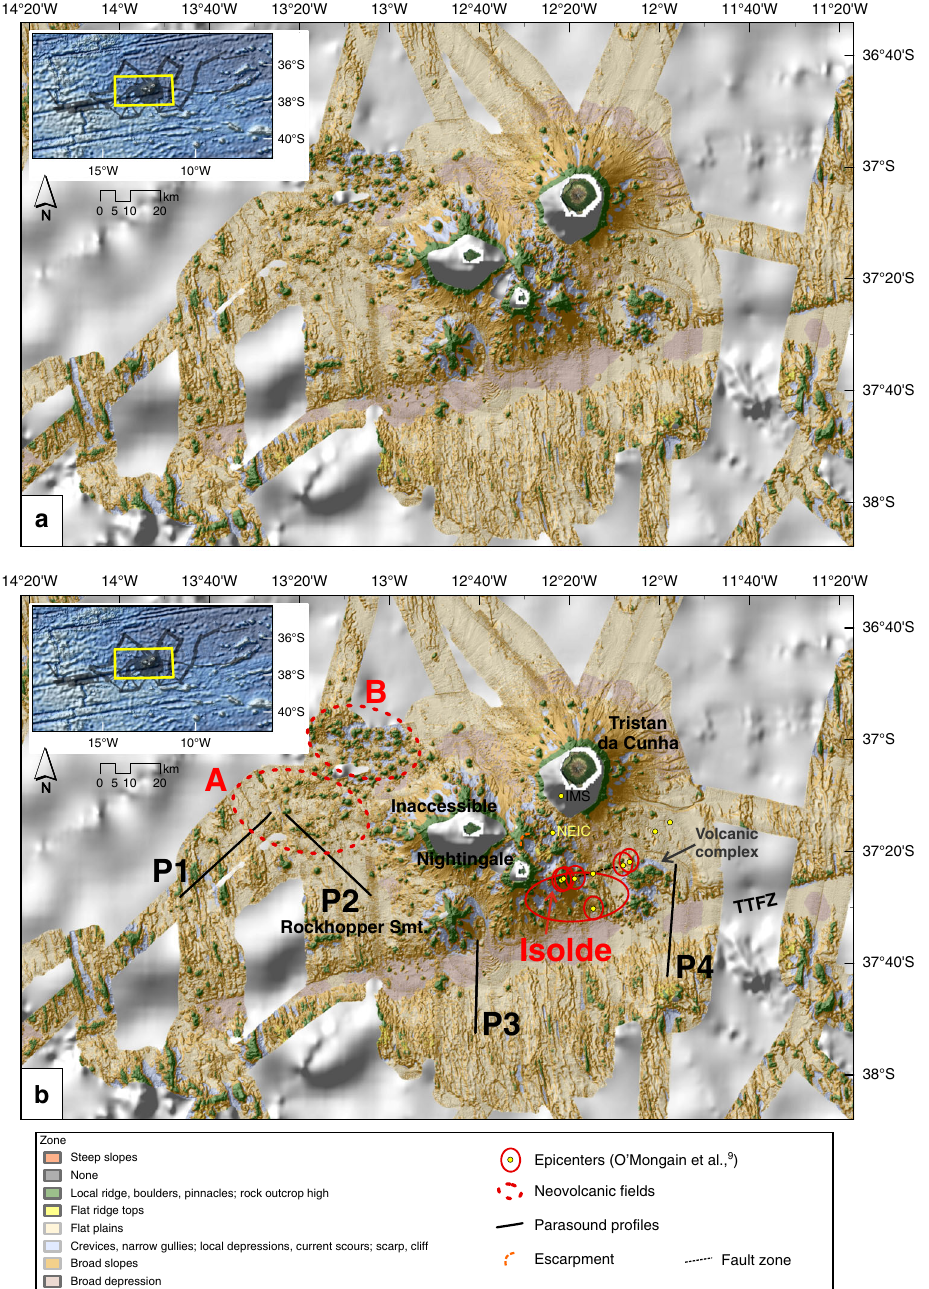
Fig. 5 Benthic Terrain Model of the central area. Benthic Terrain Model. Yellow dots with red ellipses to the SE of Nightingale Island mark local earthquake epicenters associated with submarine volcanic activity in 2004 9 , and their uncertainties. Areas A and B outline relatively young volcanic fi elds with monogenetic cones and lava fl ows. P1 to P4 mark locations of sub-bottom pro fi ler (Parasound) pro fi les. Smt. Seamount; TTFZ Tristan da Cunha Transform Fault And Fracture Zone